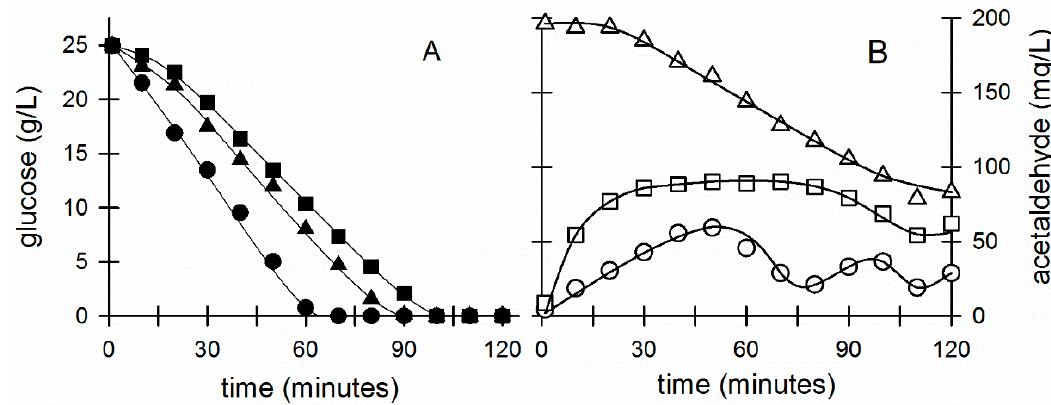
Figure 4. Effect of the addition of acetaldehyde on glucose consumption and the acetaldehyde concentration in nongrowing ethanol-stressed (90 g/L) cultures of Z. mobilis at a population of ca. 3 × 10 10 cells per mL. ( A ) Glucose profile; ( B ) acetaldehyde profile: , ethanol-stressed culture without acetaldehyde addition; , ethanol-stressed culture with 4.3 mM (190 mg/L) added acetaldehyde; , control culture without ethanol stress. The data show one of two replicate fermentations that showed the same trends.